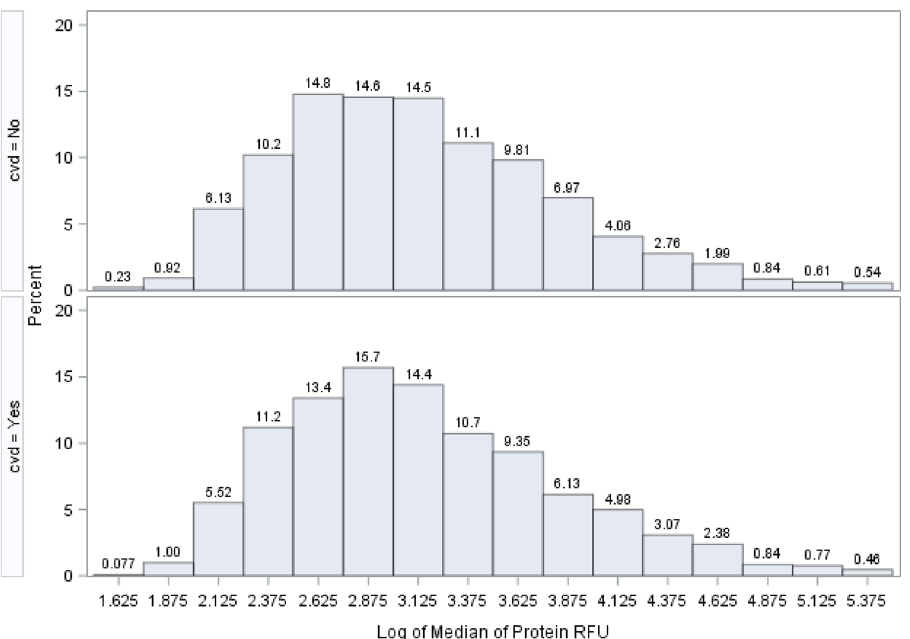
Figure 2. Distribution of the log base 10 of 1305 median estimates from 1305 proteins. Distribution of the log base 10 of 1305 median estimates from 1,305